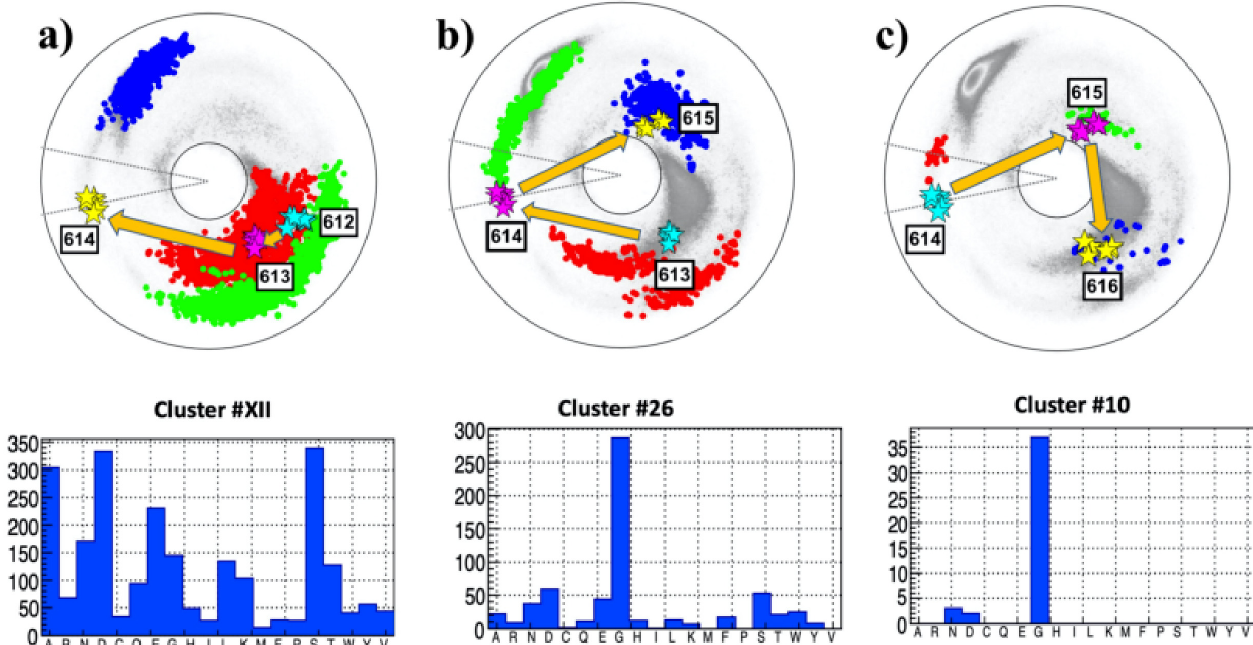
Fig 5. The ( κ , τ ) spectrum for i = 612 − 616; this engages sites 610 − 617 along the C α backbone. a) The spectrum for preceding sites P:(612, 613, 614), in i i the background of the best matching cluster #XII in [41]. The most common amino acids in the cluster are S, D, A, E, N, G. b) The spectrum for adjacent sites A:(613, 614, 615), in the background of the best matching cluster #26 in [41]. The most common amino acid in the cluster is G. c) The spectrum for following sites F:(614, 615, 616), in the background of the best matching cluster #10 in [41]. The most common amino acid in the cluster is G.